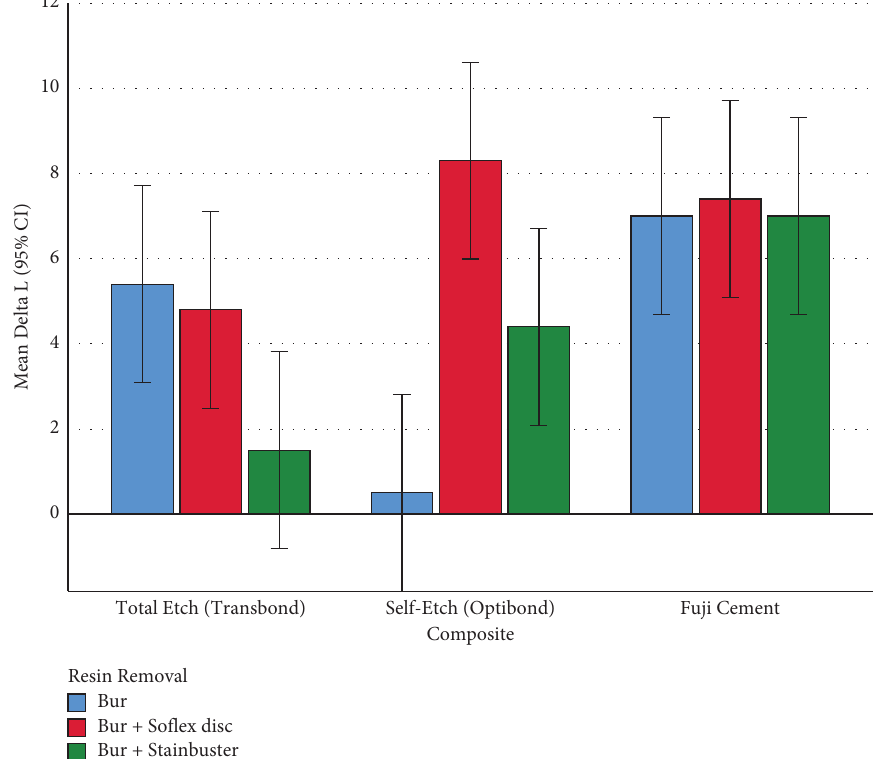
Figure 6: Means (and 95% CIs) for the Δ L parameter in all the 9 groups ( n � 9 × 10). Te values 0–100 indicate absolutely dark to absolutely bright, respectively.